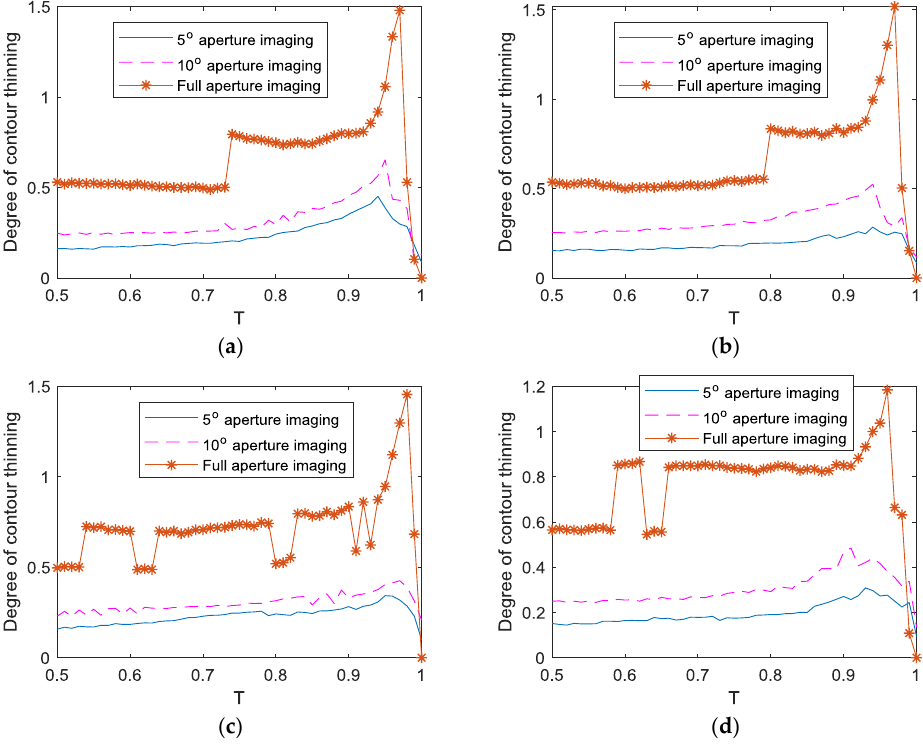
Figure 10. The degree of contour thinning varies with threshold T on different models: ( a ) Chevrolet Impala LT; ( b ) Mitsubishi Galant ES; ( c ) Toyota Highlander; ( d ) Chevrolet HHR LT. Data for 150 vehicles were randomly selected from the Goctha dataset, and they were individually imaged by the traditional backprojection algorithm and by the modulus stretch with piecewise linear transformation. Then the degree of contour thinning was calculated and is shown in Figure 11.